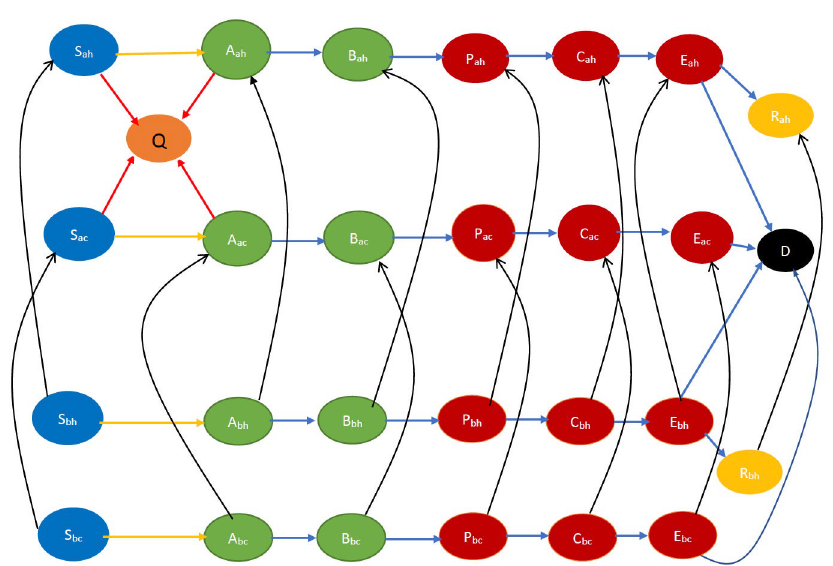
Fig 3. Smallpox disease progression overview for vaccine only scenario. Building on the definitions of states in Fig 1, the suffixes a and b respectively denote willingness to receive vaccine and otherwise e.g., S , S respectively denote ah ac immunocompetent and immunodeficient susceptibles that are willing to vaccinate. Similarly, S bh , S bc respectively denote immunocompetent and immunodeficient susceptibles that are not willing to vaccinate. The states in the top two rows and the transitions between them are identical to those in the bottom two rows except for the index “a” being replaced by “b”. The difference in this index represents a partition of these states based on the willingness to vaccinate. Sans this partition, the states and the transitions are similar to those in Fig 2—specifically, the states in the top two rows and the transitions between them, and those in the bottom two rows, by themselves, are similar to the states and the transitions in Fig 2 (except that the transition to the preempted state happens from a larger set of states in Fig 2). Table 7 in Appendix A.3 of S1 Appendix contains all the relevant abbreviations in this scenario. The states in blue color are the susceptibles (not yet infected but they are prone to infection) while those in light green color are still in incubation period, hence they are not infectious. The states in dark red are infectious while those in gold have recovered, those in yellow are immunized, and black denotes dead. In addition, the yellow arrows show susceptibles transitioning to the incubation state after contracting the virus. The blue arrows indicate the natural progression of the disease. The red arrows denote preemption via vaccination while the black arrows indicate opinion